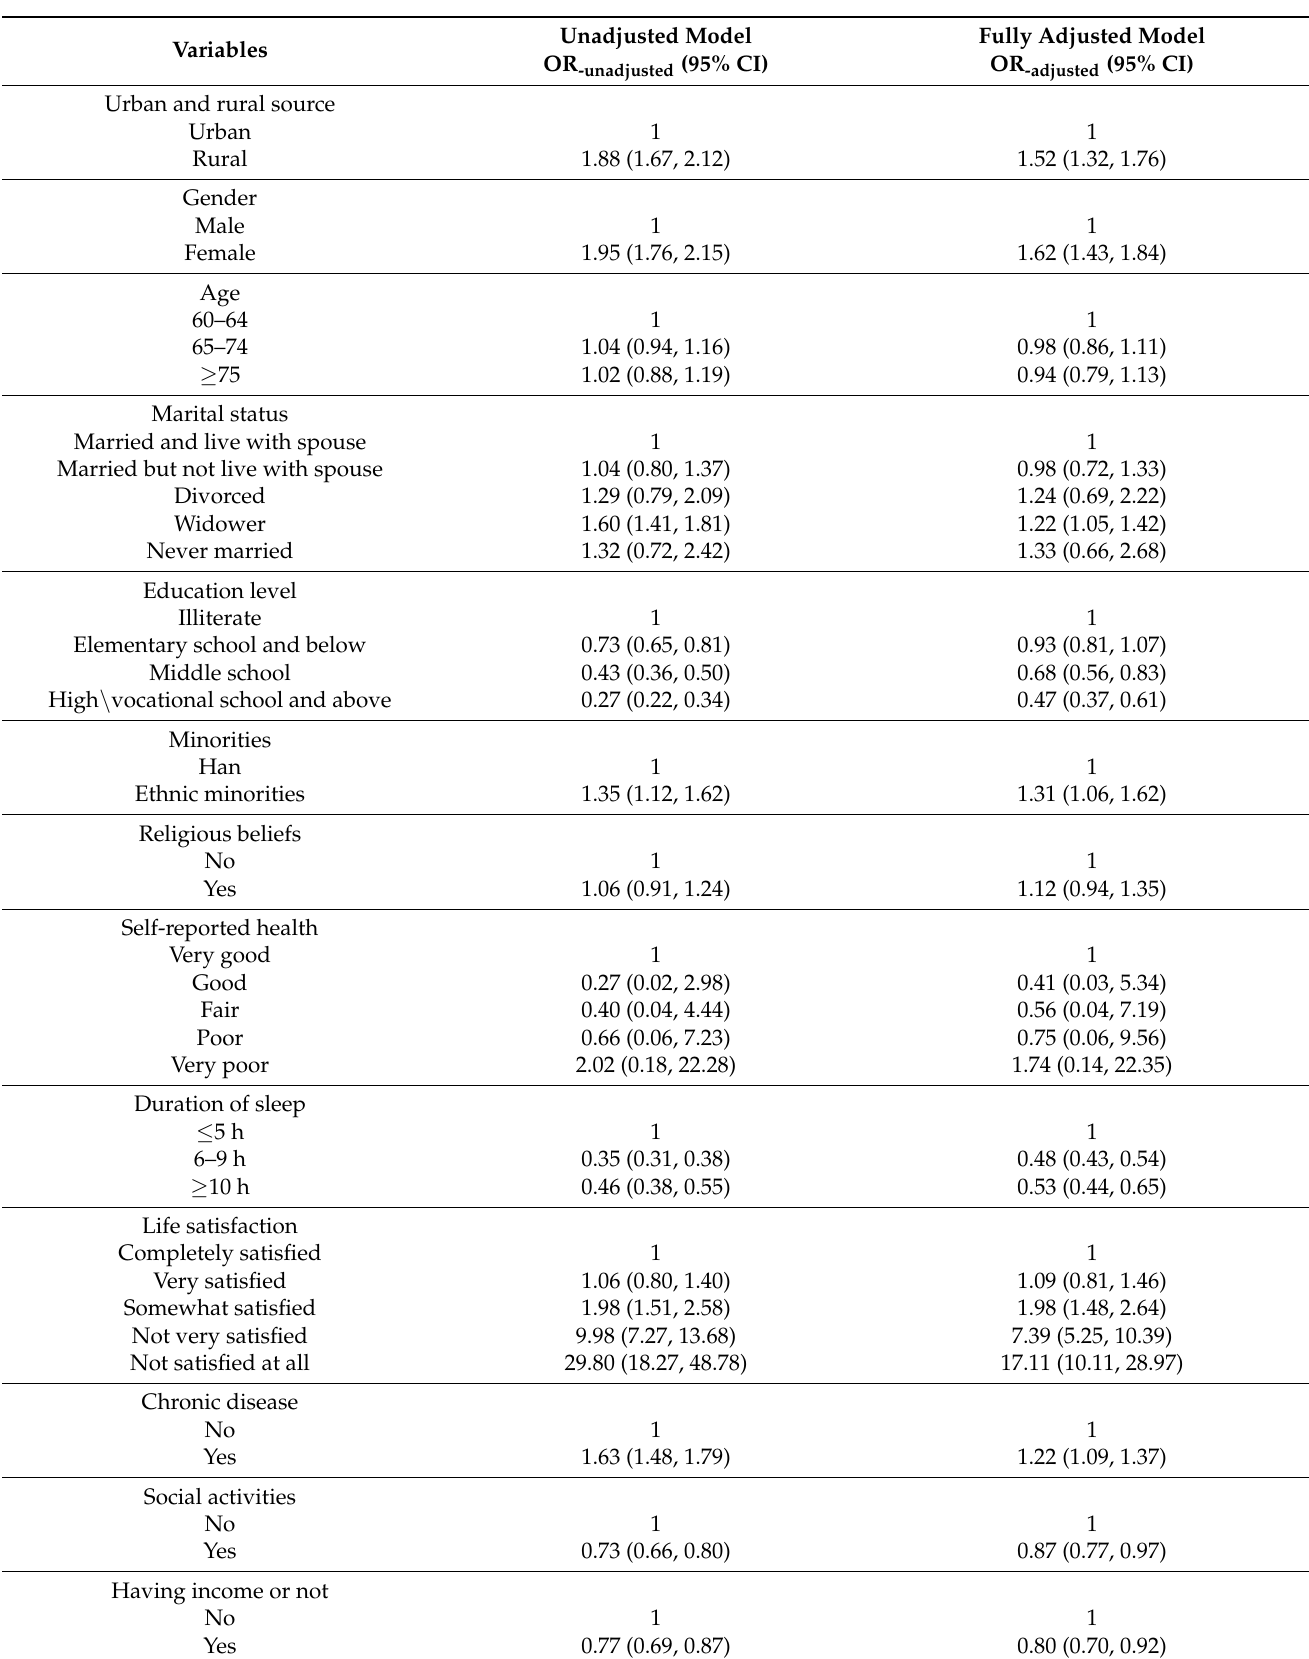
Table 3. Determinants of depression in the elderly by binary logistics regression (n =